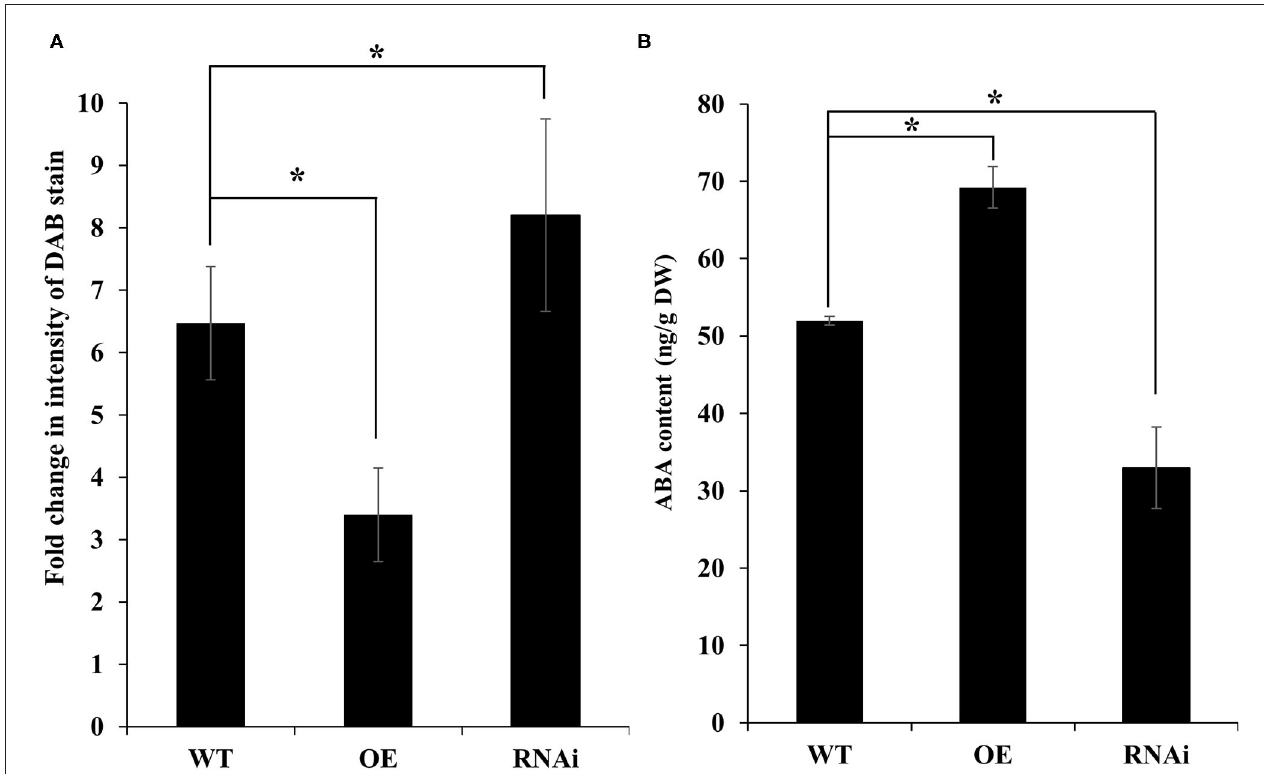
FIGURE 9 | DAB staining and ABA contents in PdNCED transgenic plants. Diaminobenzidine staining in NCED transgenic plants (A) . ABA contents of PdNCED transgenic plants (B) . Data are presented as means of at least three replications. Error bars indicate standard error. Significant differences between means at P < 0.05 are indicated by asterisks